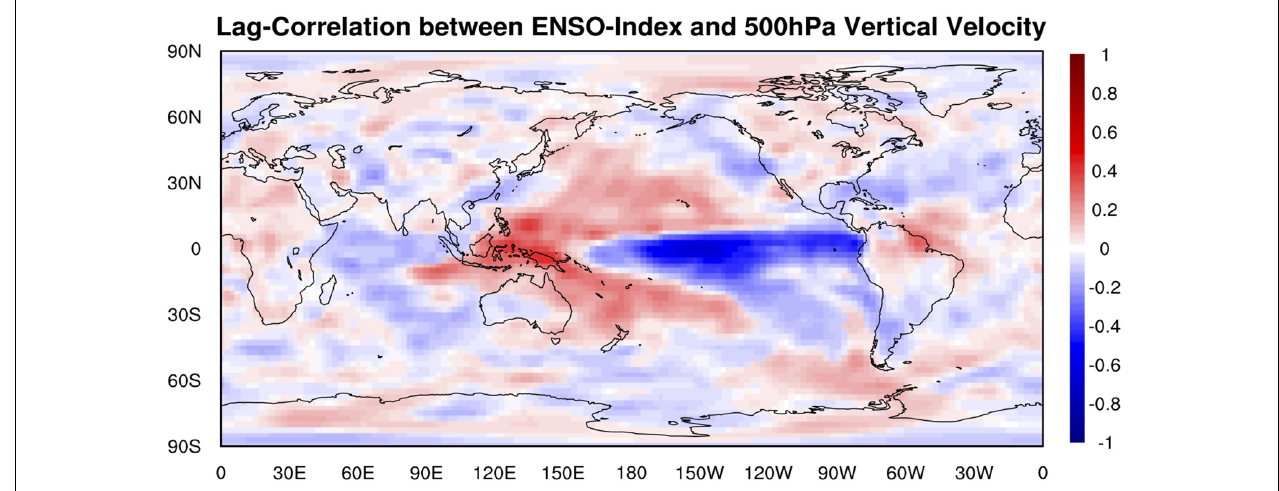
FIGURE 13 | Maximum lag correlation between ENSO index and 500 hPa vertical velocity.